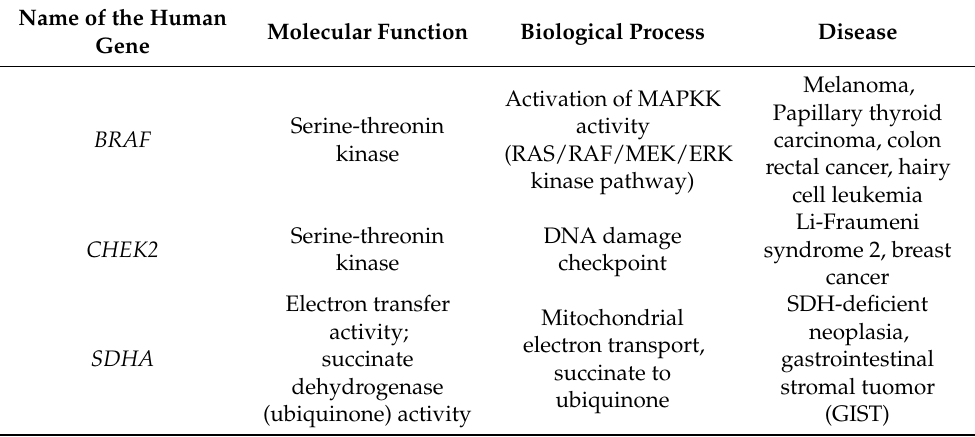
Table 3. List of genes involved in cancer that were studied in the yeast, S. cerevisiae , described in this review.